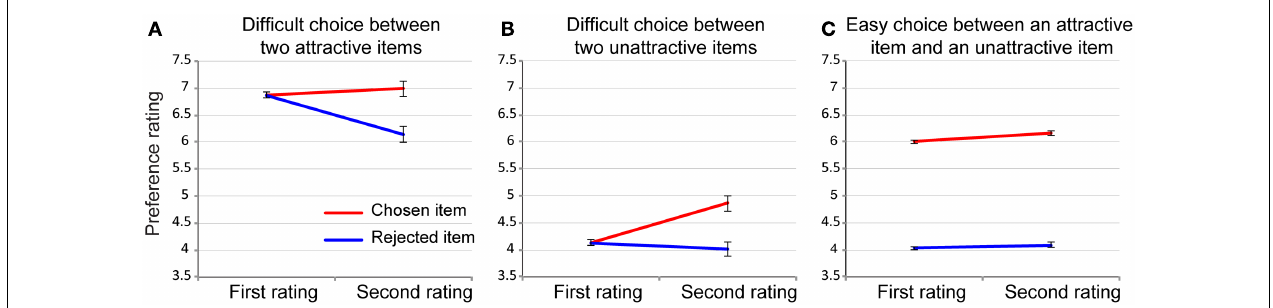
same self-report preference. (B) Preference change after difficult choice between two unattractive items of the same self-report preference. (C) Preference change after easy choice between one attractive item and one unattractive item (self-report preferences differs more than two points in the 10-point scale). Error bars depict the SEM.